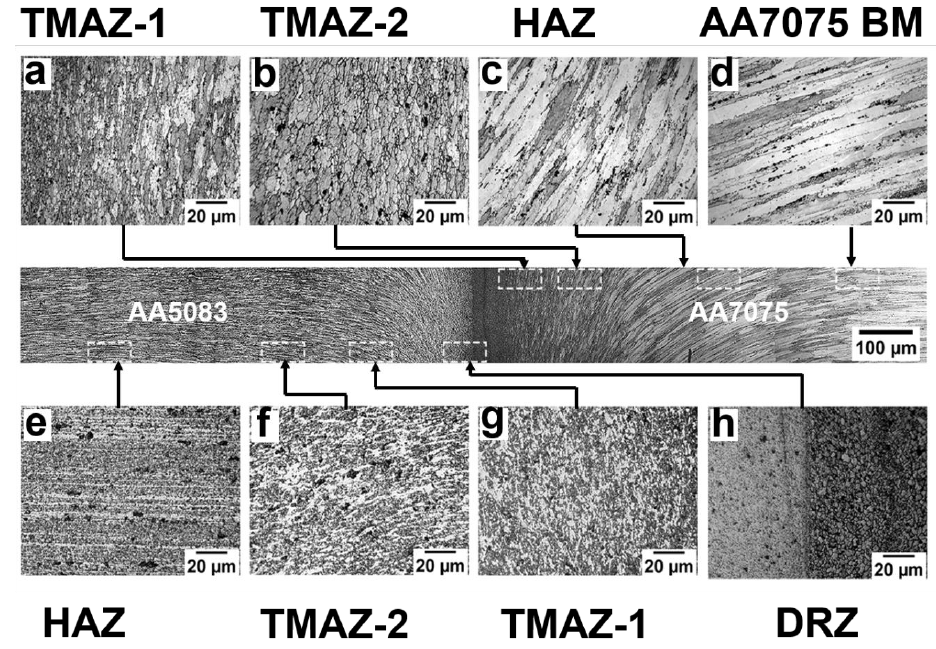
Figure 9. Microstructure across the weld interface of AA5083/AA7075-ST. AA7075 side: ( a ) TMAZ-1, ( b ) TMAZ-2, ( c ) HAZ, ( d ) base metal; AA5083 side: ( e ) HAZ, ( f ) TMAZ-2, ( g ) TMAZ-1, ( h ) DRZ.